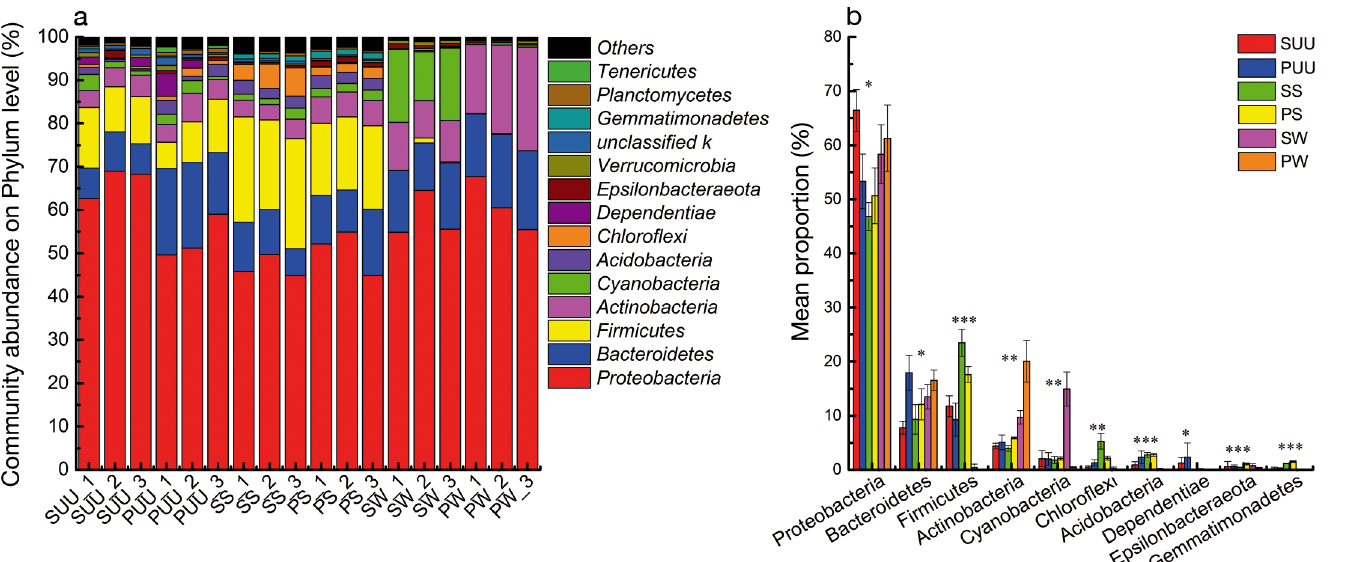
Fig. 1. Comparison of the relative abundances of major bacterial phyla in samples collected from the intestine and habitats of Urechis unicinctus . (a) Relative abundance of the top 15 phylum-level bacterial communities in all samples. (b) Top 10 phyla shared between the intestine and habitat samples. Data are presented as means ± SD. One-way ANOVA was used to detect significant differences (*0.01 < p ≤ 0.05; **0.001 < p ≤ 0.01; ***p ≤ 0.001). Sample group abbreviations as in Table